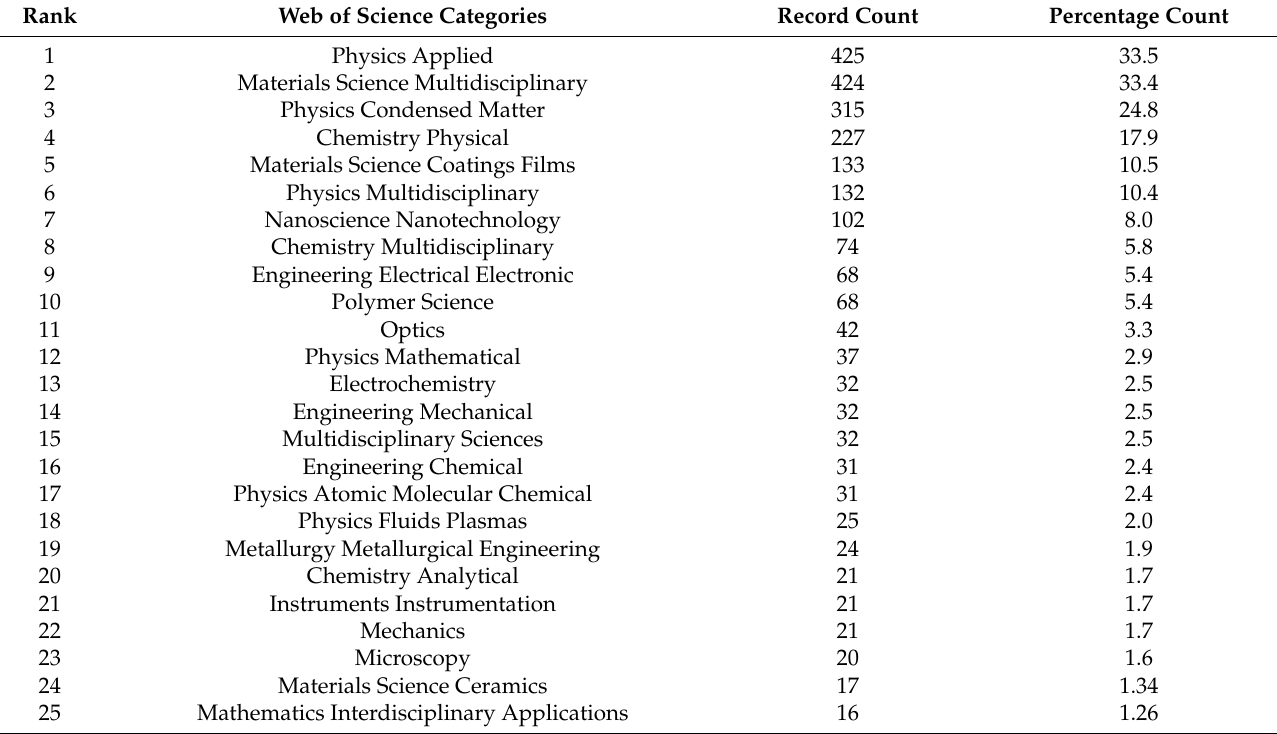
Table 4. Top twenty-five Web of Science categories on fractal theory of thin